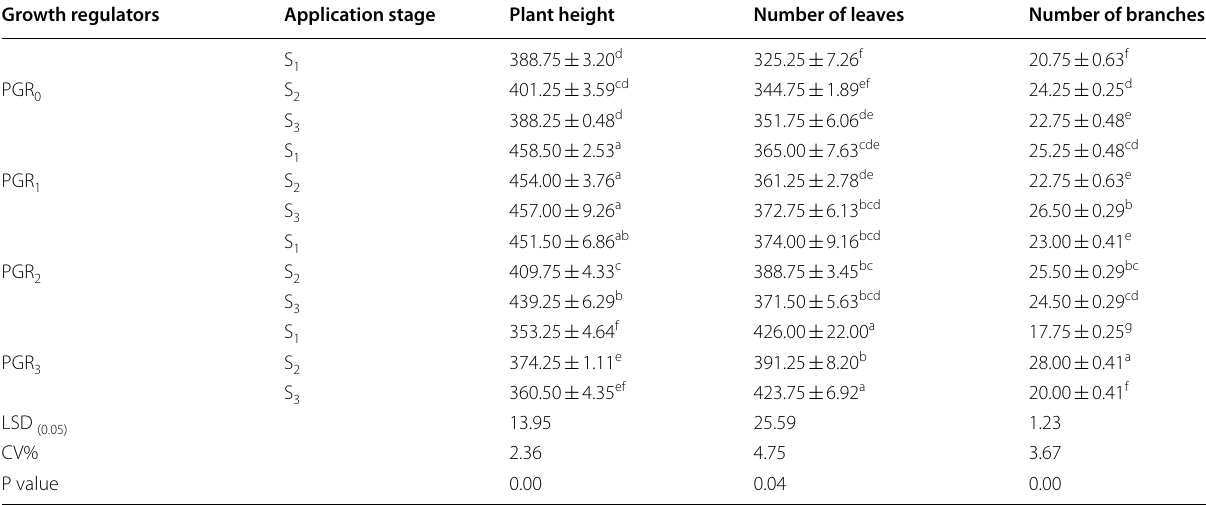
Table 1 Plant height (cm), number of leaves and number of branches per plant as influenced by plant growth regulators at different